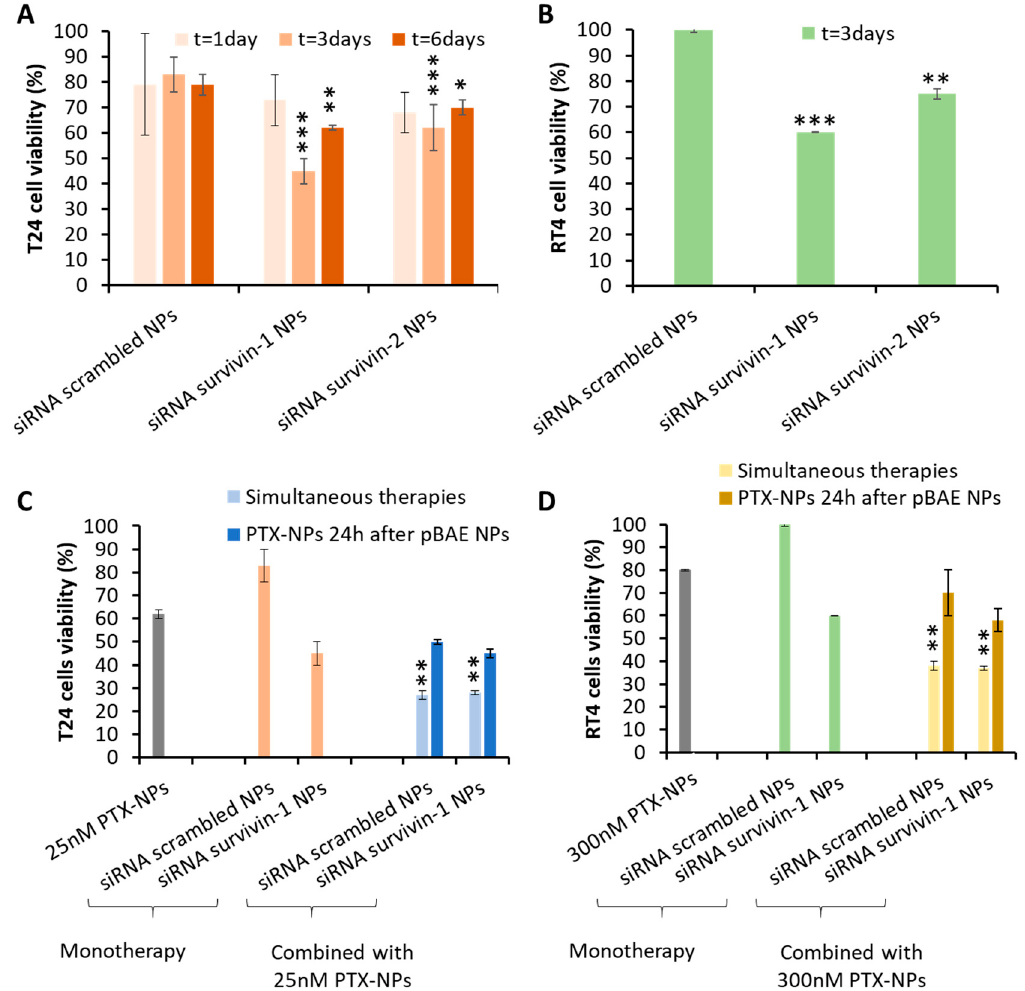
Figure 9. Tumor cells killing by pBAE nanoparticles treatment. Percentage of cell viability, after incubation with nanoparticles loaded with different siRNAs: ( A , B )—pBAE-NPs monotherapies: ( A )—T24 cells, at different times; and B—RT4 cells, at 3 days; and ( C , D )—Combined therapies study: ( C )—T24 cells; and ( D )—RT4 cells. Statistical tests comparing with the effect of the scrambled siRNA ( A , B ) or with monotherapies ( C , D ). * p < 0.05; ** p < 0.01; *** p < 0.001.